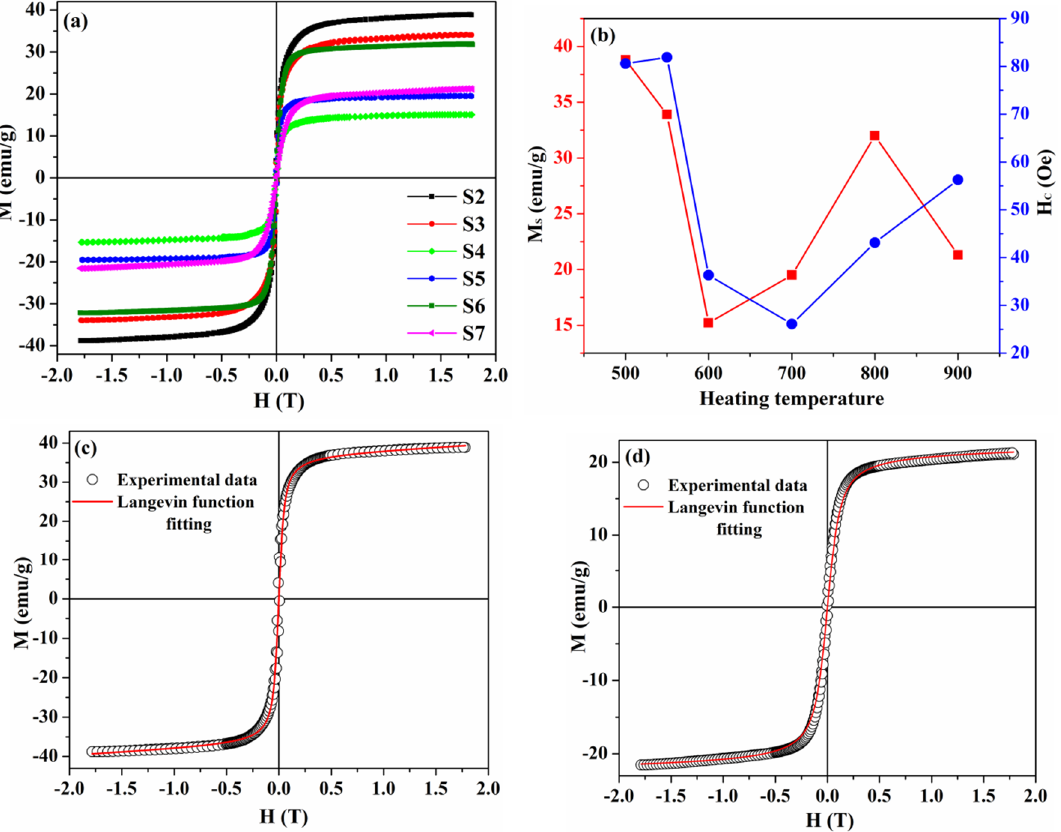
Figure 4. ( a ) Magnetic hysteresis loops of the samples, heated to various temperatures; ( b ) dependence of saturation magnetization and coercivity on heating temperature; ( c , d ) selected magnetic hysteresis loops fitted by Langevin function for samples S2 and S7, respectively.